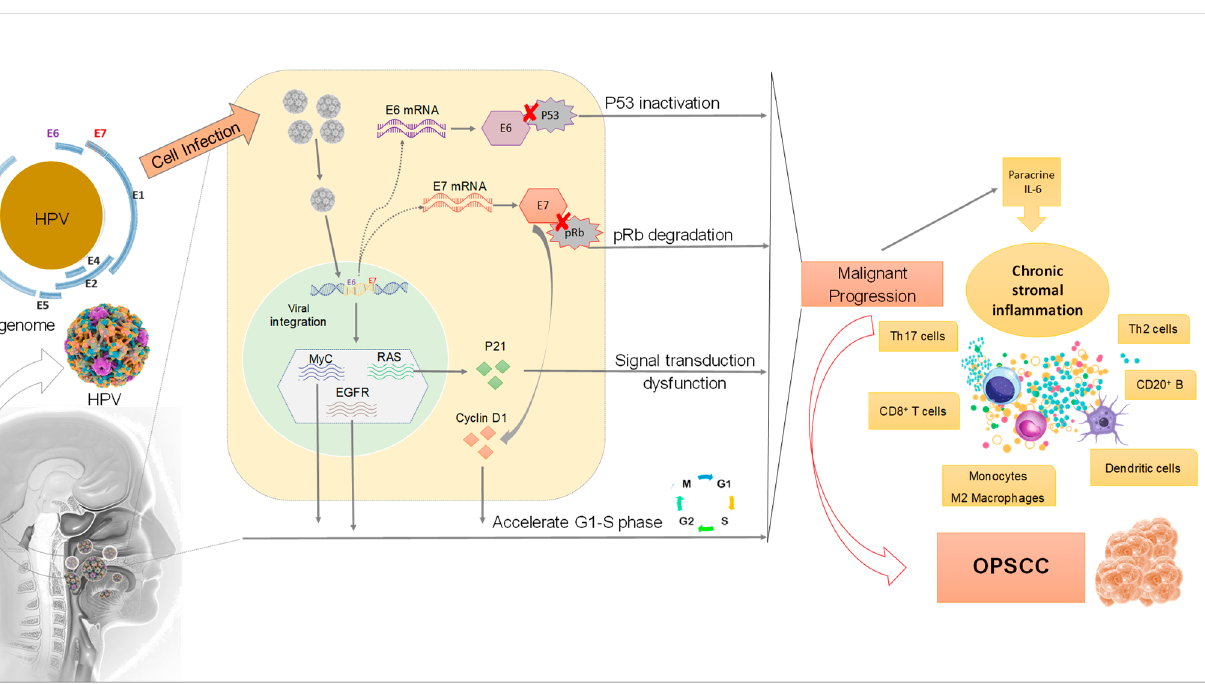
Figure 2. Mechanisms of HPV infection affecting the development of OPSCC. Once HPV infects epithelium cells in the head and neck region, its DNA is integrated into the host cell genome resulting in progressive alterations in proto-oncogenes and tumor suppressor genes. The overexpression of E6 and E7 associated with protein dysregulation in the host cells leads to dysfunction in cell metabolism and malignant proliferation.